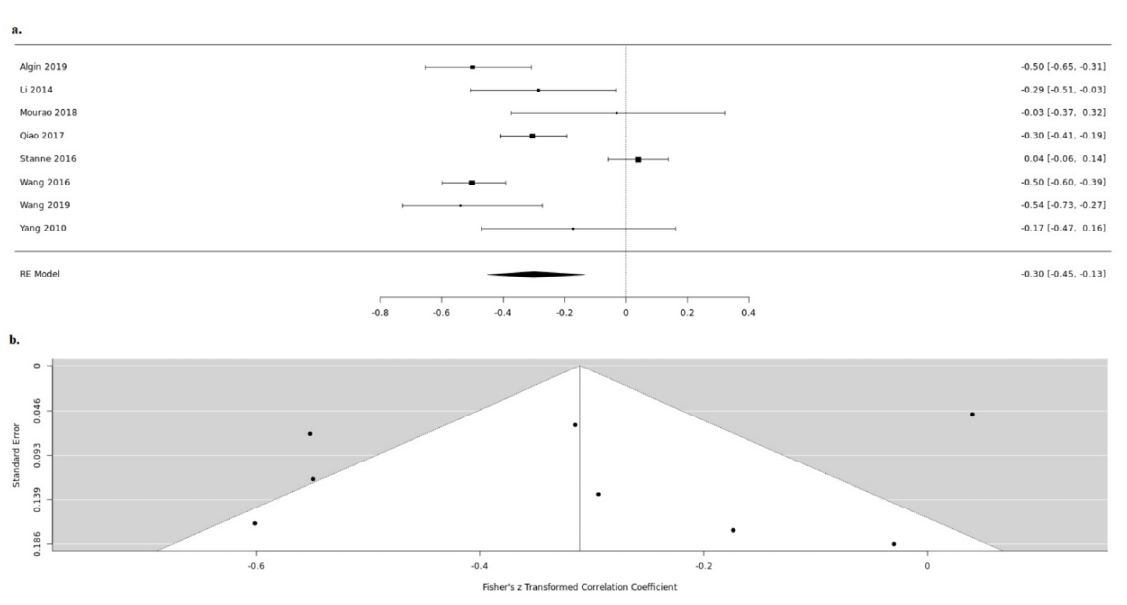
Figure 3. Serum BDNF and NIHSS up ( a ). forest and down ( b ). funnel plot.